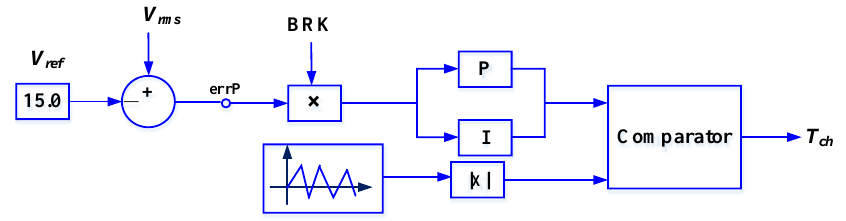
Figure 11. Active power controller for the converter.